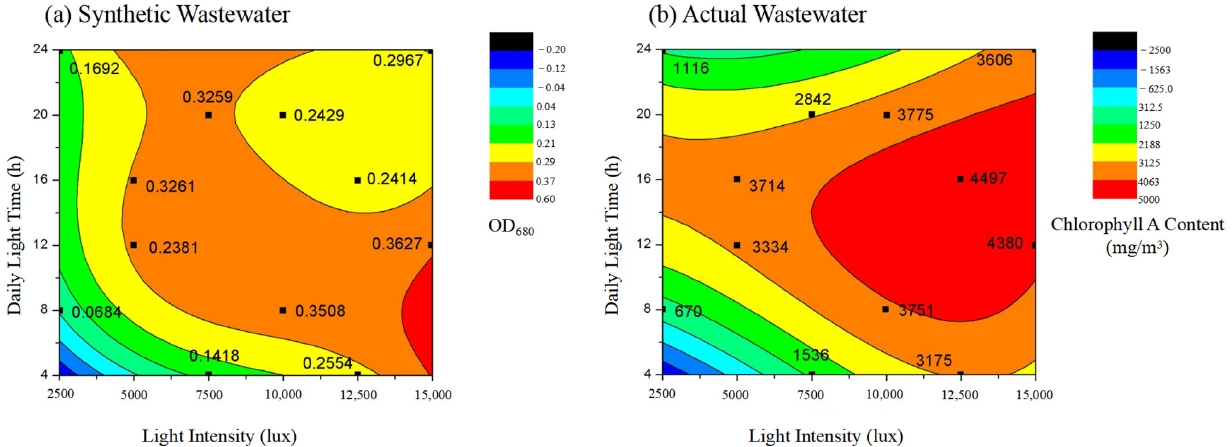
Figure 6. The contour line fitting diagram of the effect of light intensity and daily light time on the growth of Scenedesmus dimorphus : ( a ) characterized by OD 680 in synthetic wastewater; ( b ) characterized by chlorophyll a content in actual wastewater ( n = 3).